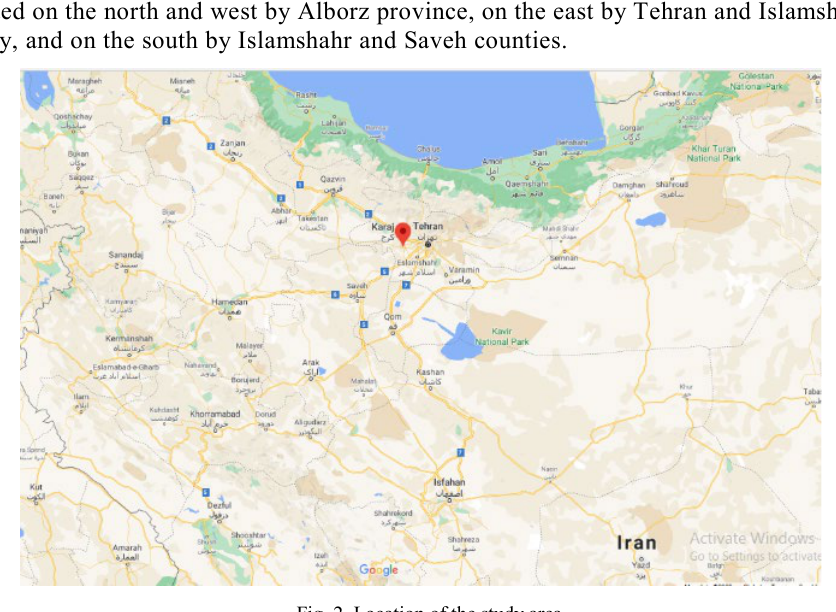
Fig. 2. Location of the study